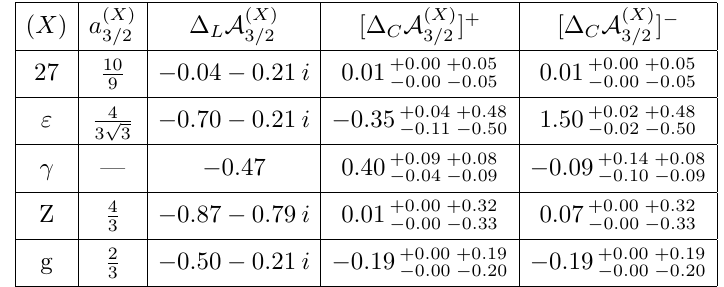
Table 5 . NLO loop and local counterterm amplitudes A amplitudes are associated with the variations of the short-distance scale (cid:22) SD and the chiral scale (cid:23) (cid:31) , respectively.